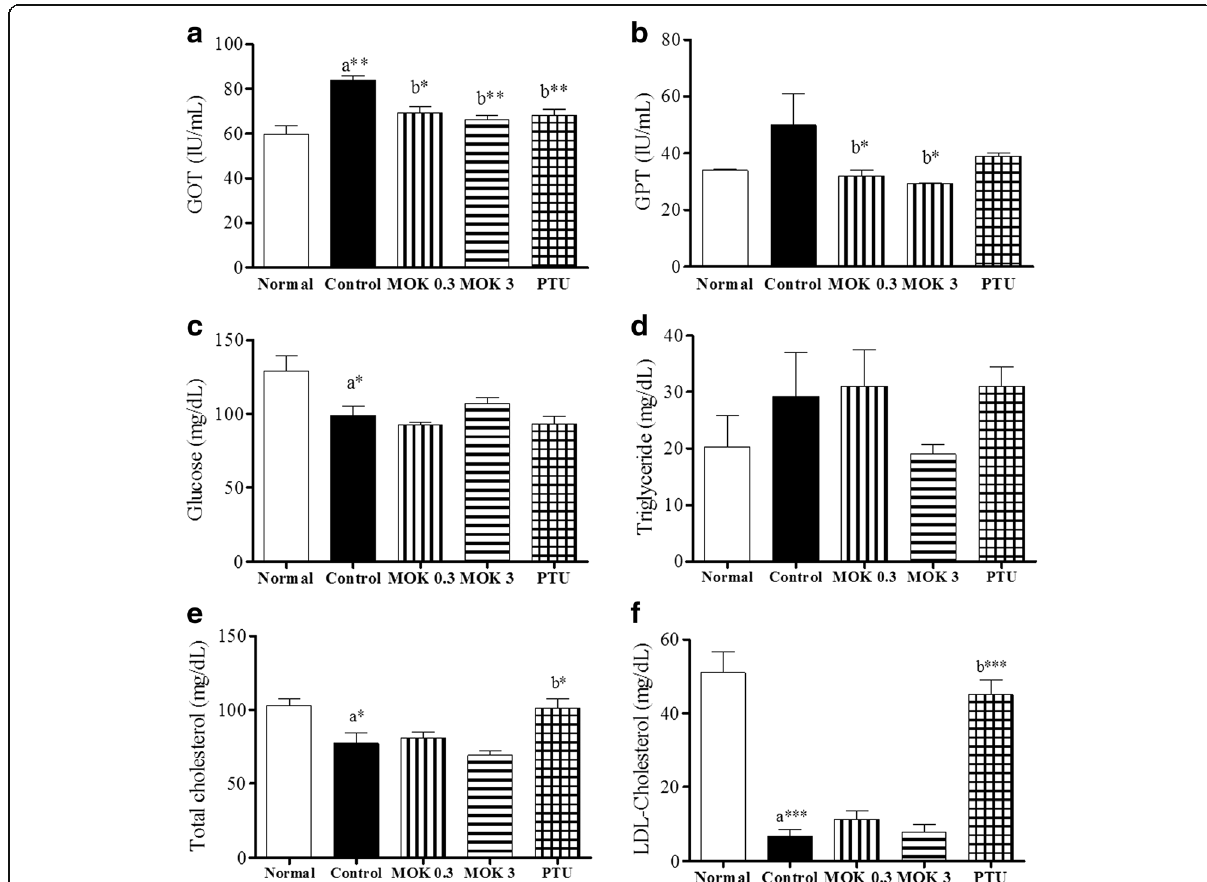
Fig. 7 Effects of MOK pharmacopuncture on the changes of serological parameters in LT4-induced hyperthyroidism rats. MOK pharmacopuncture was subcutaneously administration once daily for 2 weeks, and measured the levels of GOT ( a ), GPT ( b ), glucose ( c ), triglyceride ( d ), total-cholesterol ( e ), and LDL-cholesterol ( f ) in the sera of rats by automatic blood biochemical analyzer. Data are presented as mean±SD ( n =5 per each group). * P <0.05, ** P <0.01 and *** P <0.001 vs normal ( a ) or control ( b ). Normal, normal group; Control, LT4-induced hyperthyroidism group; MOK 0.3, MOK 0.3 mg/kg-treated group in control; MOK 3, MOK 3 mg/kg-treated group in control; and PTU, PTU 10 mg/kg-treated group as a reference